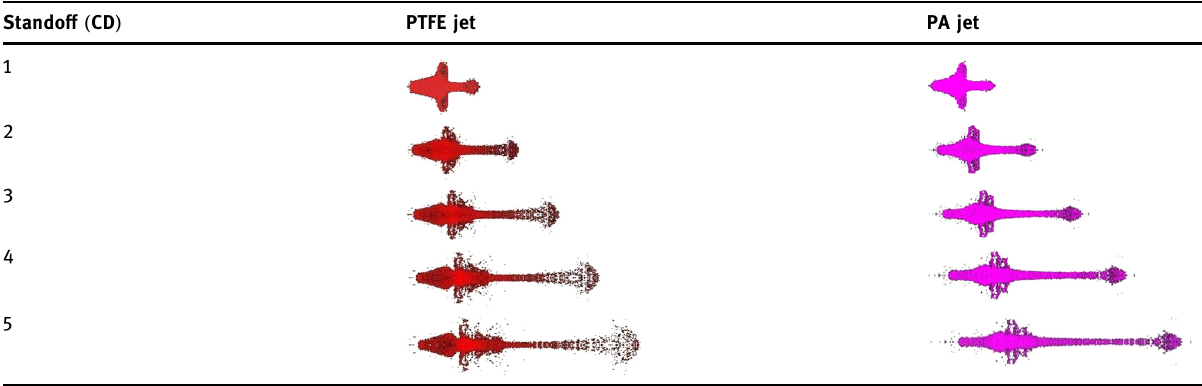
Table 4: Morphologies of the two polymer expansive jets at di ff erent stando ff s Stando ff ( CD